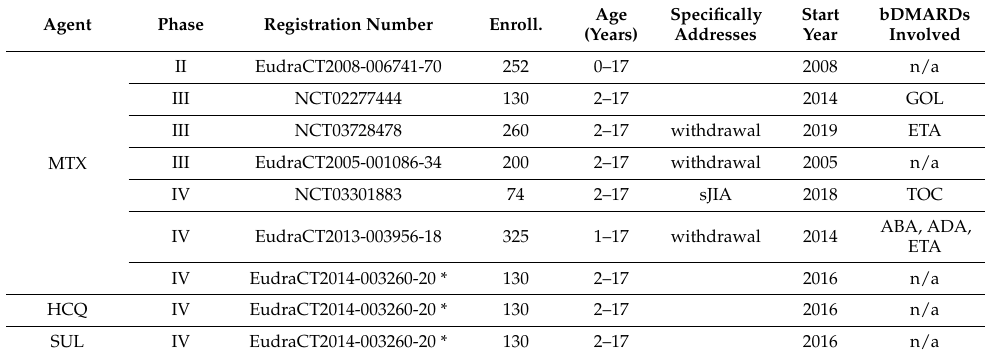
Table 1. Registered interventional studies involving csDMARD agents, clinical phases, and planned enrollments. * refers to a study involving multiple csDMARDs. sJIA—systemic JIA.